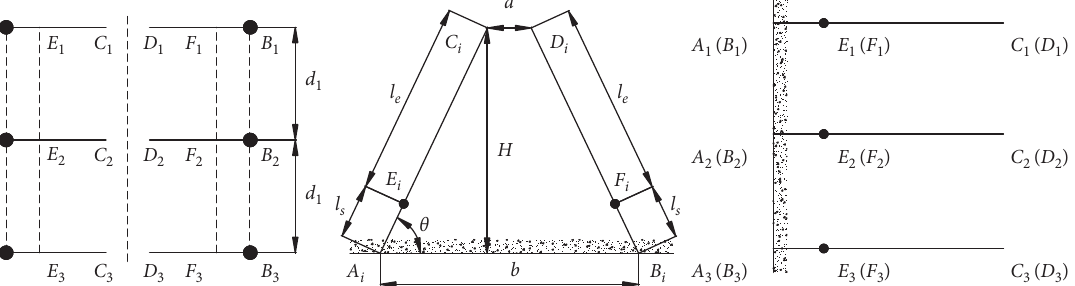
Figure 1: Cuthole arrangement in V-cut.